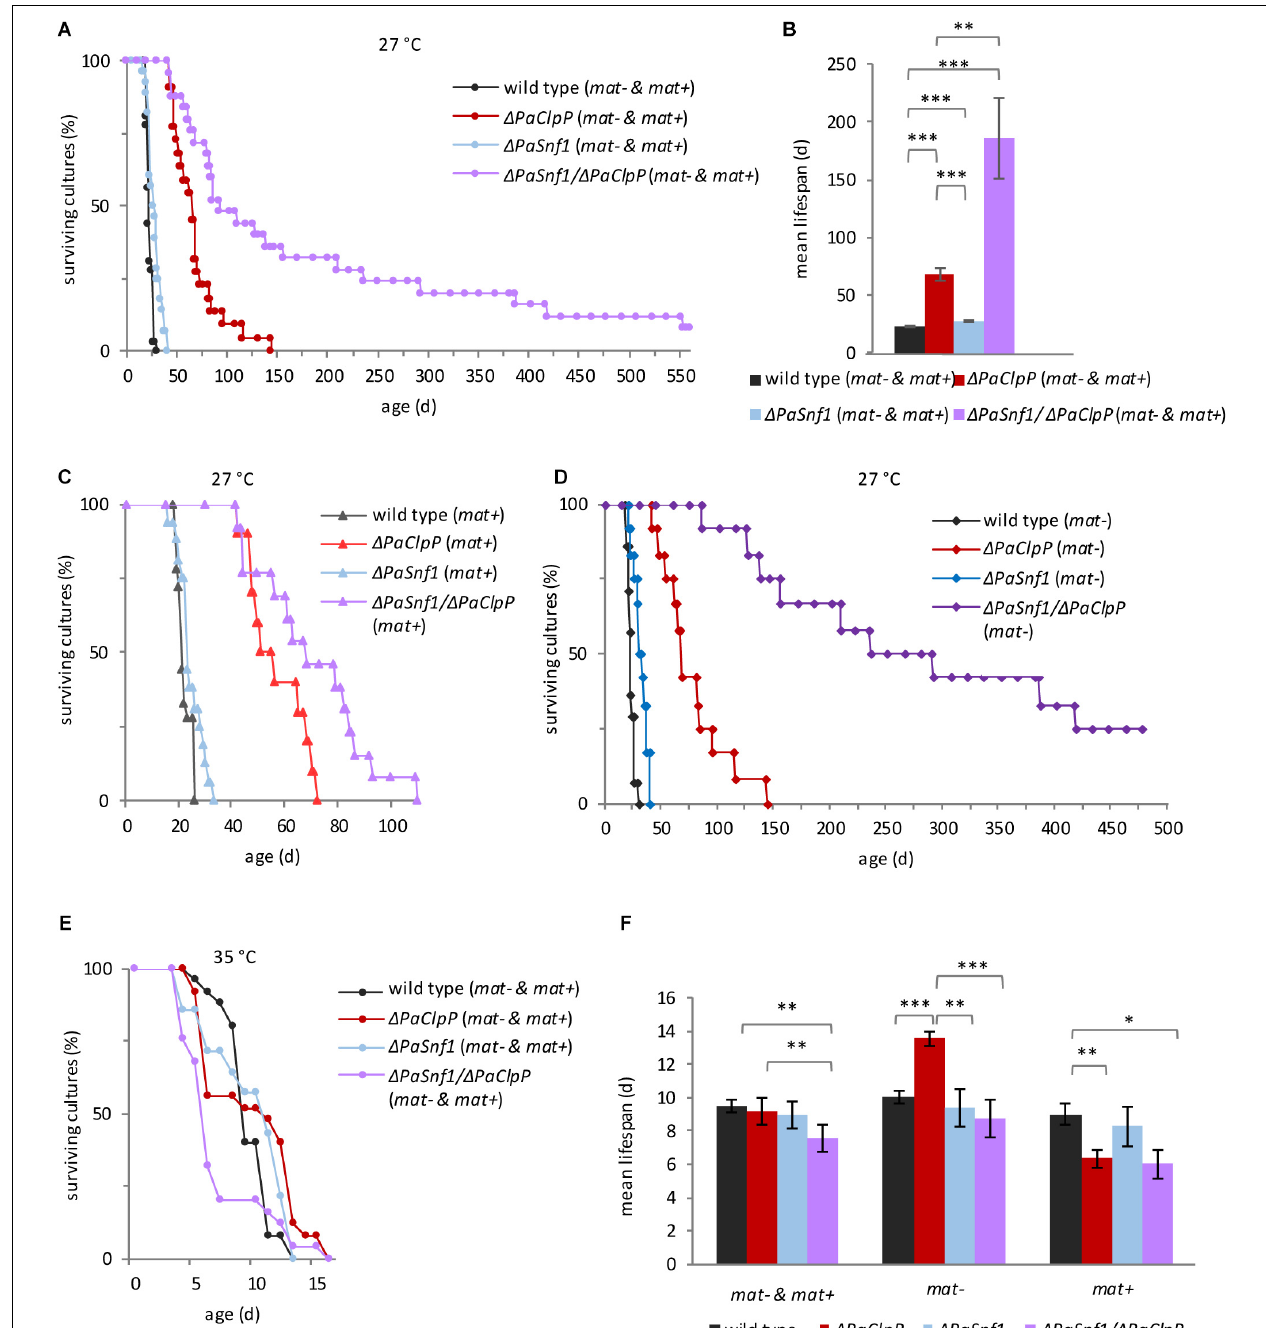
FIGURE 3 | PaSNF1 impacts on lifespan. (A,B) Lifespan analysis at 27 ◦ C of (cid:49) PaSnf1 ( n = 28, p < 0.001), (cid:49) PaClpP ( n = 22, p < 0.001), (cid:49) PaSnf1 / (cid:49) PaClpP ( n = 25, p < 0.001), and the wild type ( n = 32), grown on M2 medium in constant light. (B) Mean lifespan of cultures from panel (A) . (C) Lifespan analysis at 27 ◦ C of (cid:49) PaSnf1 ( mat+ ) ( n = 16, p = 0.0389), (cid:49) PaClpP ( mat+ ) ( n = 10, p = 0.0058), (cid:49) PaSnf1 / (cid:49) PaClpP ( mat+ ) ( n = 13, p < 0.001), and wild type ( mat+ ) ( n = 18) on M2 medium in constant light. “( mat+ )” represents the mating type “plus” ( rmp1-2 ). (D) Lifespan analysis at 27 ◦ C of (cid:49) PaSnf1 ( mat– ) ( n = 12, p < 0.001), (cid:49) PaClpP ( mat– ) ( n = 12, p < 0.001), (cid:49) PaSnf1 / (cid:49) PaClpP ( mat– ) ( n = 12, p < 0.001), and wild type ( mat– ) ( n = 14) on M2 medium in constant light. “( mat– )” represents the mating type “minus” ( rmp1-1 ). (E) Lifespan analysis at 35 ◦ C of (cid:49) PaSnf1 ( n = 17, p = 0.523), (cid:49) PaClpP ( n = 28, p = 0.691), (cid:49) PaSnf1 / (cid:49) PaClpP ( n = 19, p = 0.024), and wild type ( n = 25), grown on M2 medium in constant light. (F) Mean lifespan of cultures from panel (E) . ( A,B,E , and left group in panel F ): the data of strains of both mating types are combined (“ mat– & mat+ ”). (A,C–E ): p -values of the lifespan curves in comparison to wild type were determined by SPSS with three different statistic tests. A compilation of all p -values is provided in Supplementary Tables 2, 3 . (B,F) Shown are mean values ± SEM ( ∗∗∗ p < 0.001; ∗∗ p < 0.01; * p < 0.05, two-tailed Student’s t -test).